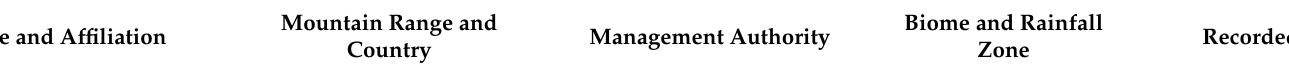
Park (”Table Mountain”) SAEON Fynbos node; proposed component of